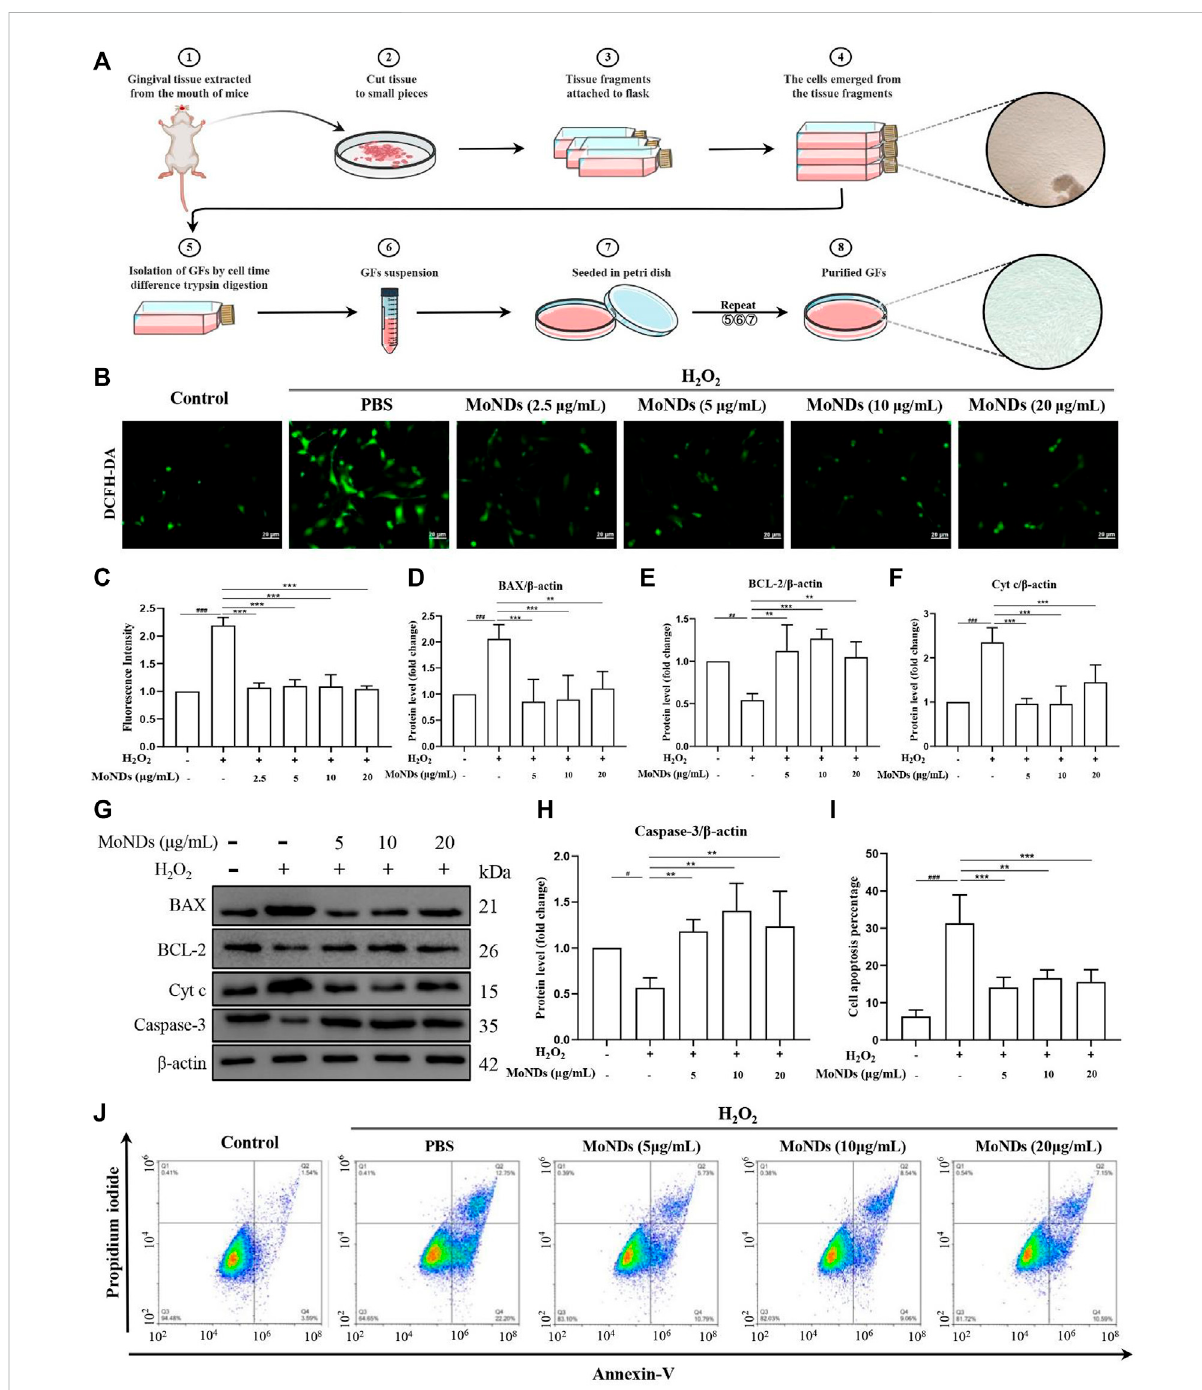
FIGURE 4 MoNDs alleviated oxidative stress in primary gingival fi broblasts. (A) Schematic illustration of the gingival fi broblast extraction process. (B) Measurement of ROS levels in gingiva fi broblasts from each group using a DCFH-DA probe (green). Scale bar: 20 μ m. (C) Quanti fi cation of the fl uorescence signal intensity of ROS. (D – H) Western blot analysis of apoptosis-related protein (BAX, BCL-2, Cyt c, and caspase-3) expression in primarygingival fi broblasts.Alldataarepresentedasthemean±S.D.( n =3).ThequantitativestatisticalresultsofapoptoticcellratiosbyAnnexin V-FITC/PI fl ow cytometry (I) and the representative image (J)